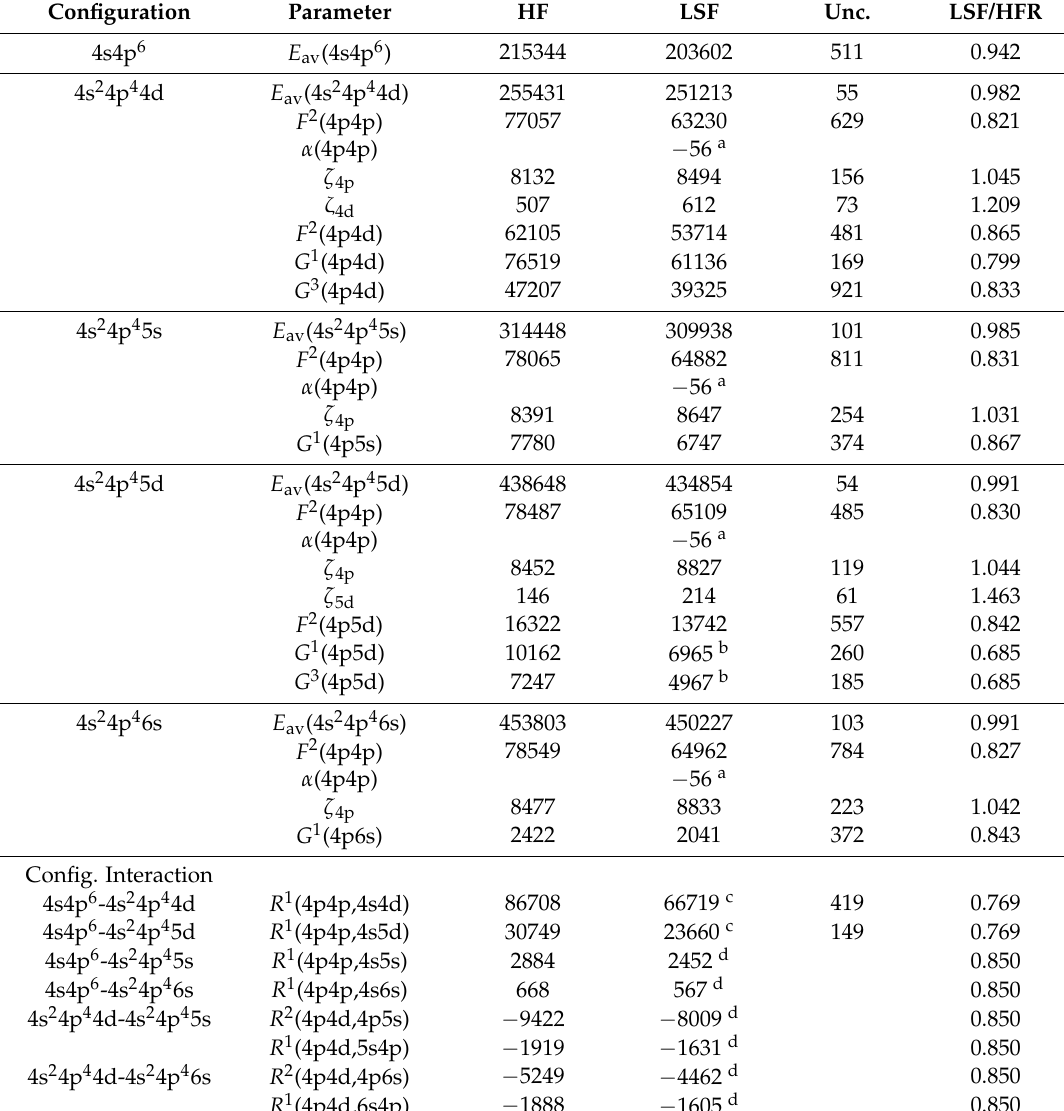
Table 6. Hartree-Fock and least-squares fitted parameters for the even configurations of Y V. Mean error of fit 273 cm − 1